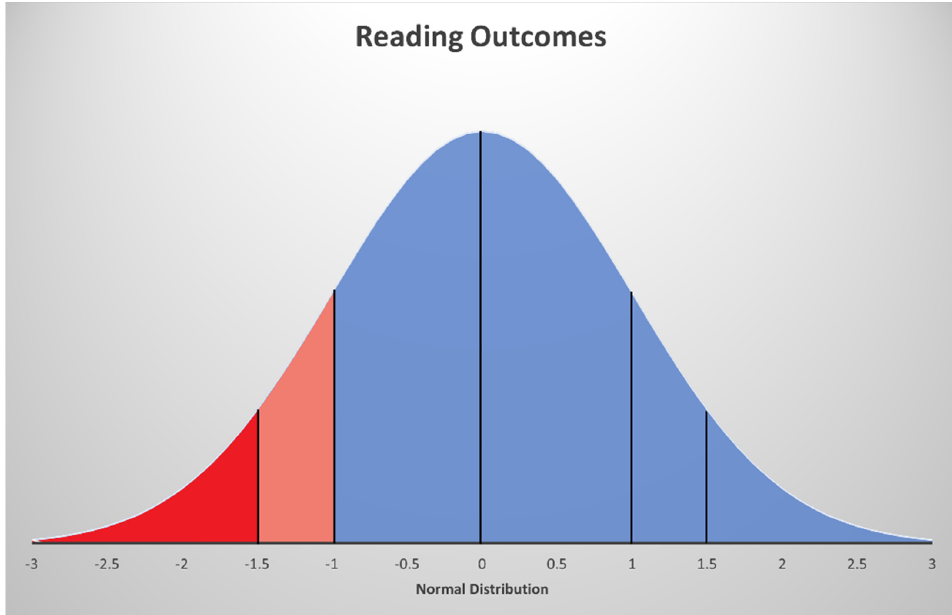
Figure 1. Comparison of categorical cut points in dyslexia definition. Note: red = cases of dyslexia ( − 1.5.SD or more below the mean are likely identified); orange = possible cases or controls (between − 1 SD and − 1.5 SD below the mean may be identified depending on the judgement of the assessor); blue = controls (identified as not having dyslexia).